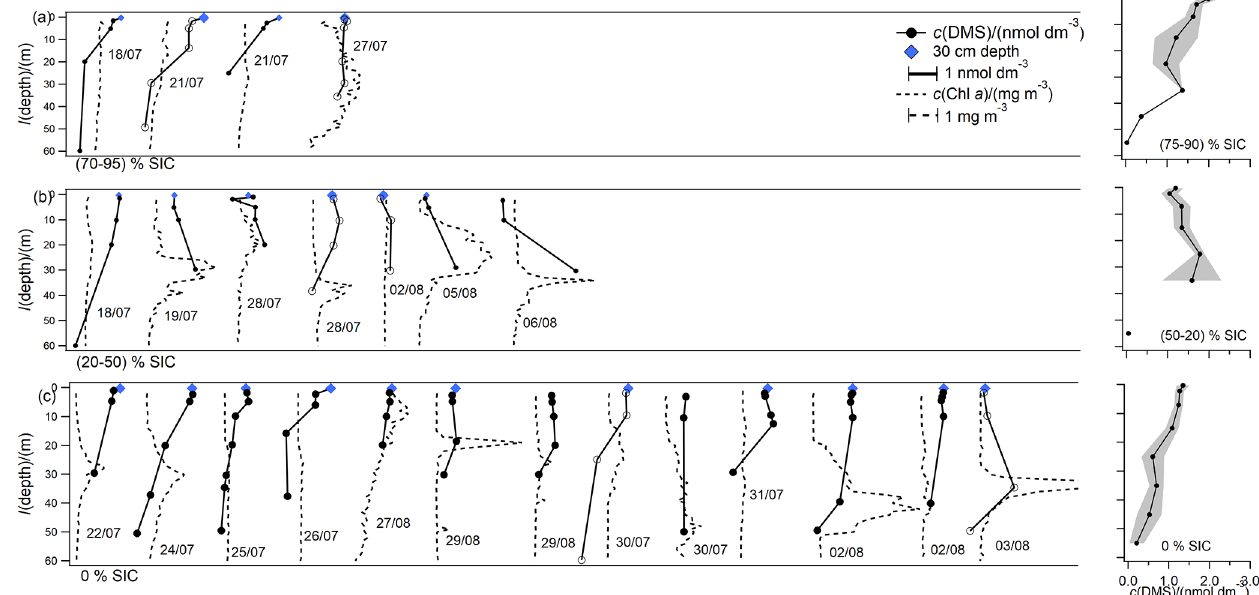
Figure 5. Overview plot displaying the shape of all DMS and Chl a depth profiles, grouped by SIC and staggered along the x axis for ease of viewing. Panel labels indicate the SIC bin. The scale bars for DMS and Chl a in (a) also apply to (b) and (c) . Profiles with hollow markers are highlighted in Fig. 7. One of the Chl a profiles is cut off in (c) for scale purposes. Sampling dates are indicated to locate stations using Fig. 1. Panels (d) to (f) indicate absolute concentrations of mean vertical profiles grouped according to ice cover and binned by depth horizons. The shaded area indicates standard error for each depth